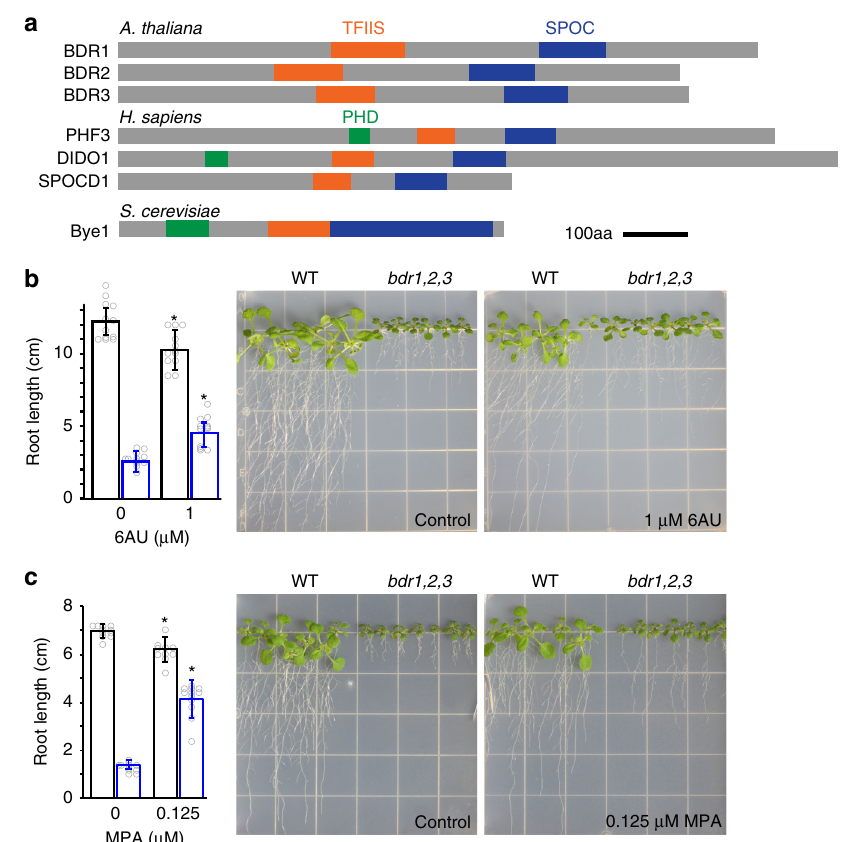
Fig. 1 Reduced root growth in the bdr1,2,3 mutant is partially restored by inhibitors of transcriptional elongation. a Schematic drawing of BDR proteins and related proteins from humans and yeast. b , c The short-root phenotype of bdr1,2,3 is partially rescued by the transcription elongation inhibitors 6AU ( b ) and MPA ( c ). Wild type and bdr1,2,3 are represented by black and blue bars, respectively ( n = 12 biologically independent seedlings). Error bars indicate one standard deviation. Asterisks indicate signi fi cant differences ( p <